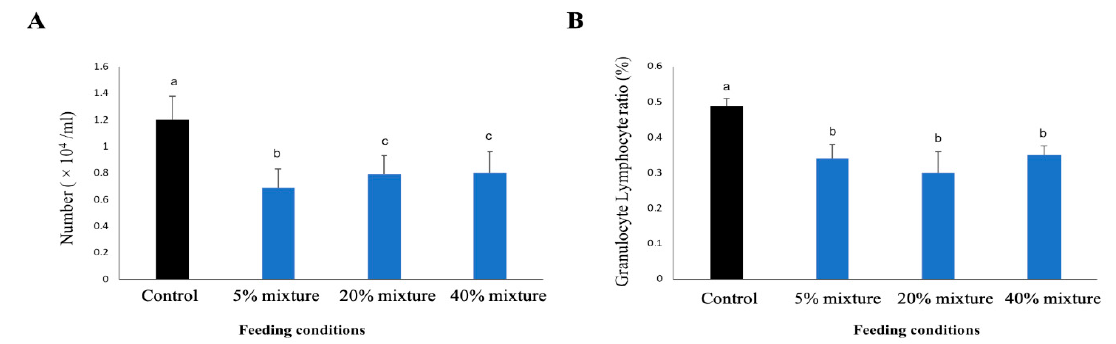
Figure 7. White bold Cell (WBC) count ( A ) and the ratio of granulocyte and lymphocyte ( B ) in the peripheral of study pigs at 17 weeks of their age. Results presented are the mean ± SD of three independent experiments. Different letters upon the bar indicate significant difference at 5% ( p < 0.05) while same letters indicate no significance difference when compared two bars.